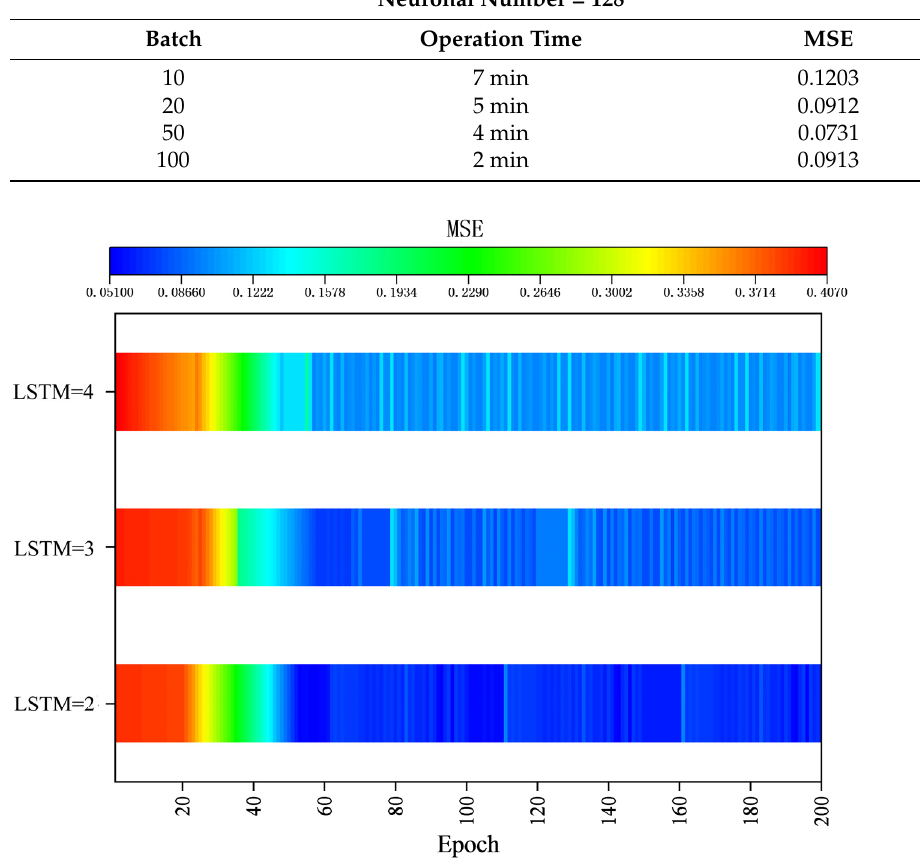
Figure 6. Comparison of LSTM layer losses.